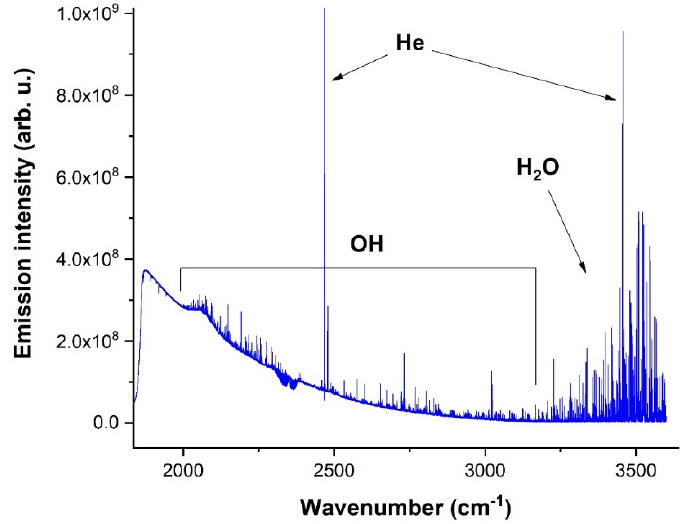
Figure 5. Averaged spectrum of OH radical in the 1800–3500 cm − 1 spectral region.